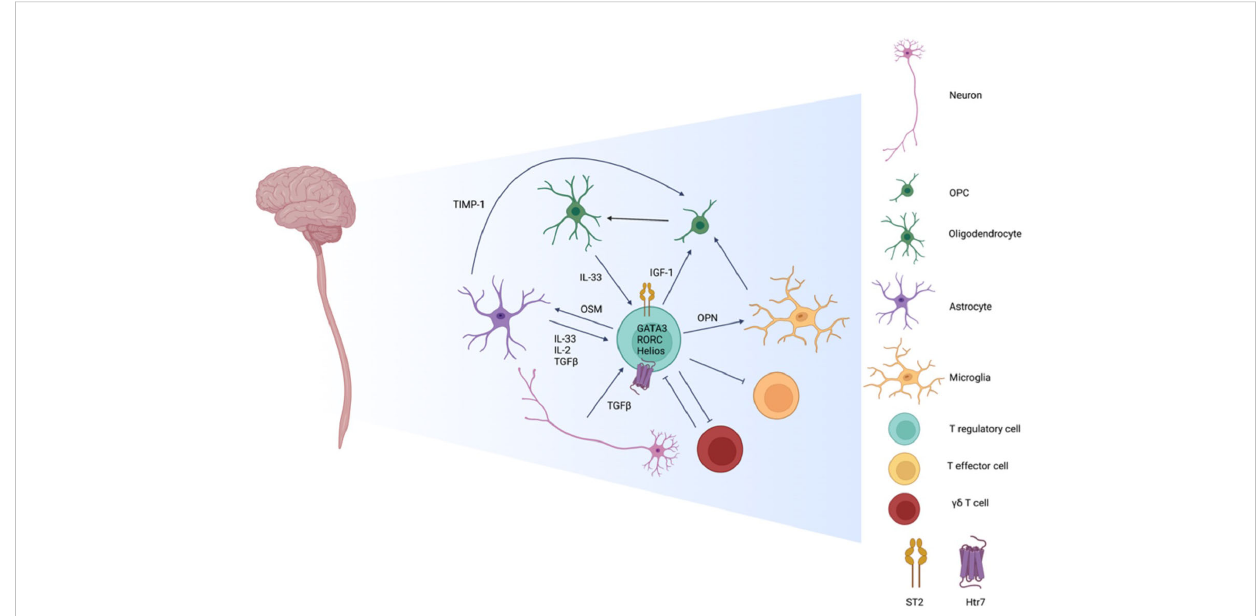
FIGURE 4 Interactions amongst Tregs and cells residing in the CNS. CNS Resident Tregs are primarily of thymic origin noted by Helios expression and have a tissue speci fi c pro fi le marked by comparatively elevated expression of the IL-33 receptor ST2, the serotonin receptor Htr7, and the transcription factors GATA3 and RORC. While CNS resident Tregs have higher expression of activation markers, in comparison to peripheral Tregs, they are as ef fi cient in suppressing T effector cells. During in fl ammation and disease, in fl ammatory gd T cells are one of the fi rst immune in fi ltrates and shape the initial phase of insult by suppressing the Treg pool. At the resolution phase, the roles reverse as Treg numbers expand while gd T cells diminish. CNS resident Tregs adopt a non-immune role of shaping the environment by promoting remyelination in varies capacities. The differentiation of oligodendrocyte precursor cells (OPCs) to mature oligodendrocyte is in fl uenced directly by Treg derived insulin like growth and factor 1 (IGF-1). Indirect means include Treg priming of microglia and astrocytes by osteopontin (OPN) and oncostatin M (OSM), respectively, to promote OPC differentiation via tissue inhibitor of metalloproteinases-1 (TIMP-1). Neurons and glial cells also regulate Tregs by secreting IL-33, IL-2, and TGF- b to support local Tregs function and